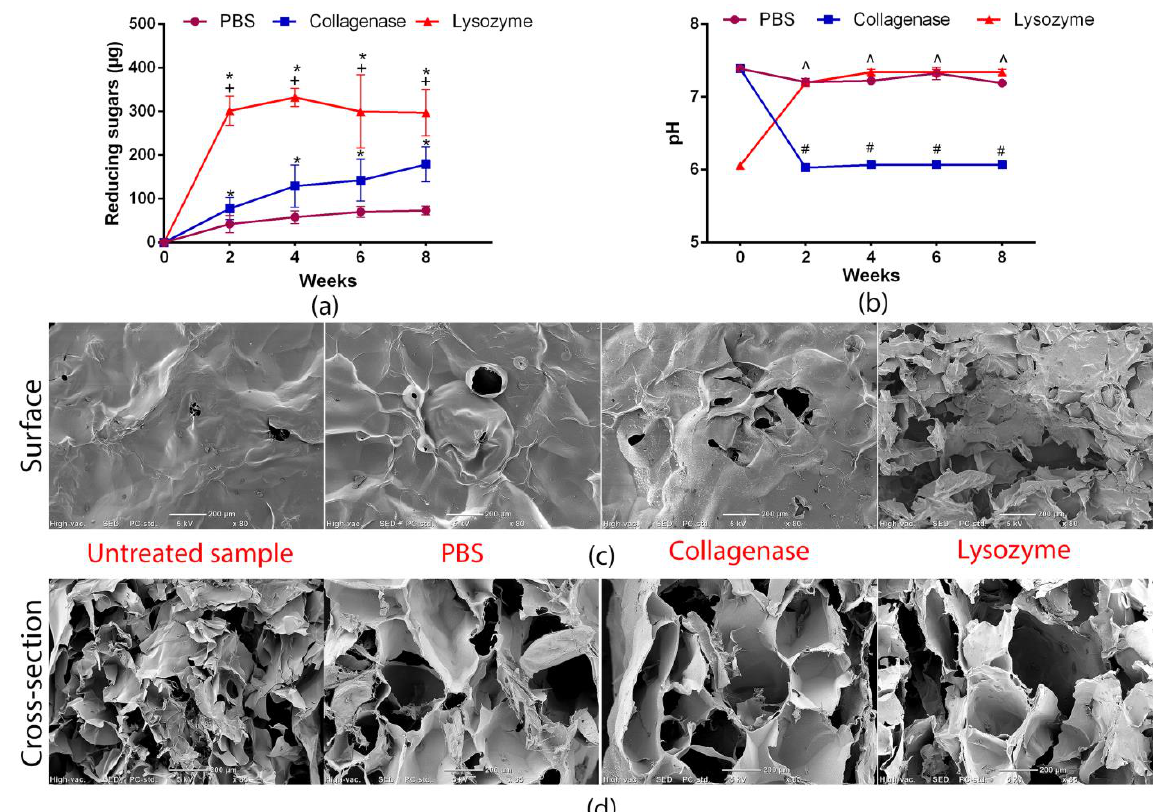
Figure 5. Results obtained with biodegradation test: ( a ) Concentrations of the reducing sugars in the degradation solutions (* statistically significant results compared to PBS, + statistically significant results compared to the solution with collagenases (mixture of MMP-1 and MMP-8); p value < 0.05, One-way ANOVA followed by Tukey ′ s test); ( b ) Changes in the pH values with time (# statistically significant results compared to the initial pH (7.4) of the collagenase solution, ^ statistically significant results compared to the initial pH (6.0) of the lysozyme solution; p value < 0.05, unpaired t -test); ( c ) SEM visualization of the biomaterial top surface after enzymatic and non-enzymatic degradation; ( d ) SEM visualization of the biomaterial cross-section after enzymatic and non-enzymatic degradation.